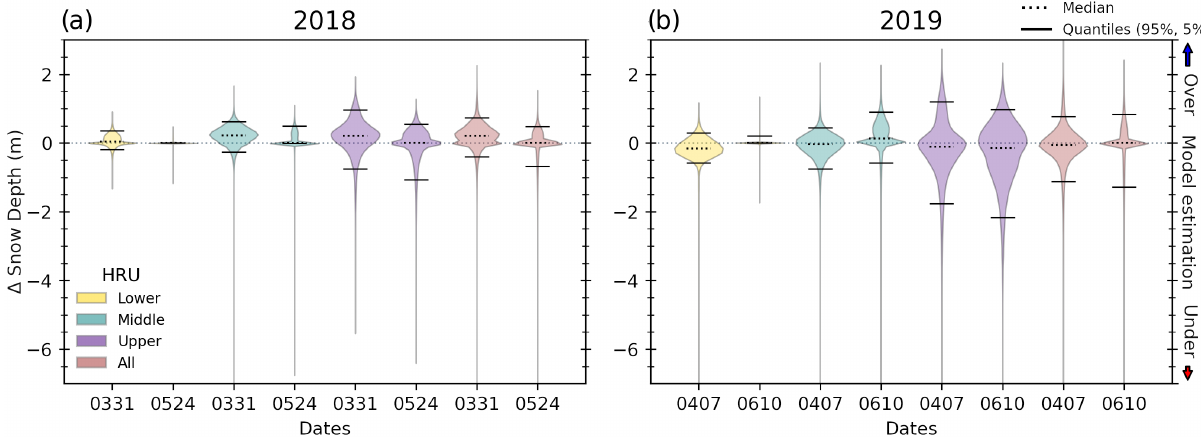
Figure 5. Snow depth differences for early and late surveys for the years 2018 and 2019 between HRRR-iSnobal and ASO. Panels (a) and (b) categorize the differences by elevation HRU (low, middle, upper), with “All” showing the basin-wide difference. Table 2. Overview of precipitation inputs and SWE outputs for HRRR-iSnobal and SNOW-17 classified by HRU. HRU 2018 2019 2020 2021 Precip. SWE Precip. SWE Precip. SWE Precip. SWE HRRR-iSnobal 300 7352 496 24976 265 12897 325 12183 Lower SNOW-17 333 5888 566 26653 413 16816 418 13509 Ratio 90% 125% 88% 94% 64% 77% 78% 90% HRRR-iSnobal 491 30567 796 66744 471 34448 468 31574 Middle SNOW-17 495 25375 859 67347 573 39788 606 37270 Ratio 99% 120% 93% 99% 82% 87% 77% 85% HRRR-iSnobal 667 45639 1076 107478 49037 Upper SNOW-17 707 59676 1196 135108 723 75563 832 74739 Ratio 94% 76% 90% 80% 91% 69% 72% 66% HRRR-iSnobal 1458 83558 2368 199198 1394 99521 1392 92794 All SNOW-17 1535 90939 2621 229108 1709 132167 1856 125518 Total 95% 92% 90% 87% 82% 75% 75% 74% Note: precipitation (Precip.) and SWE values are shown in